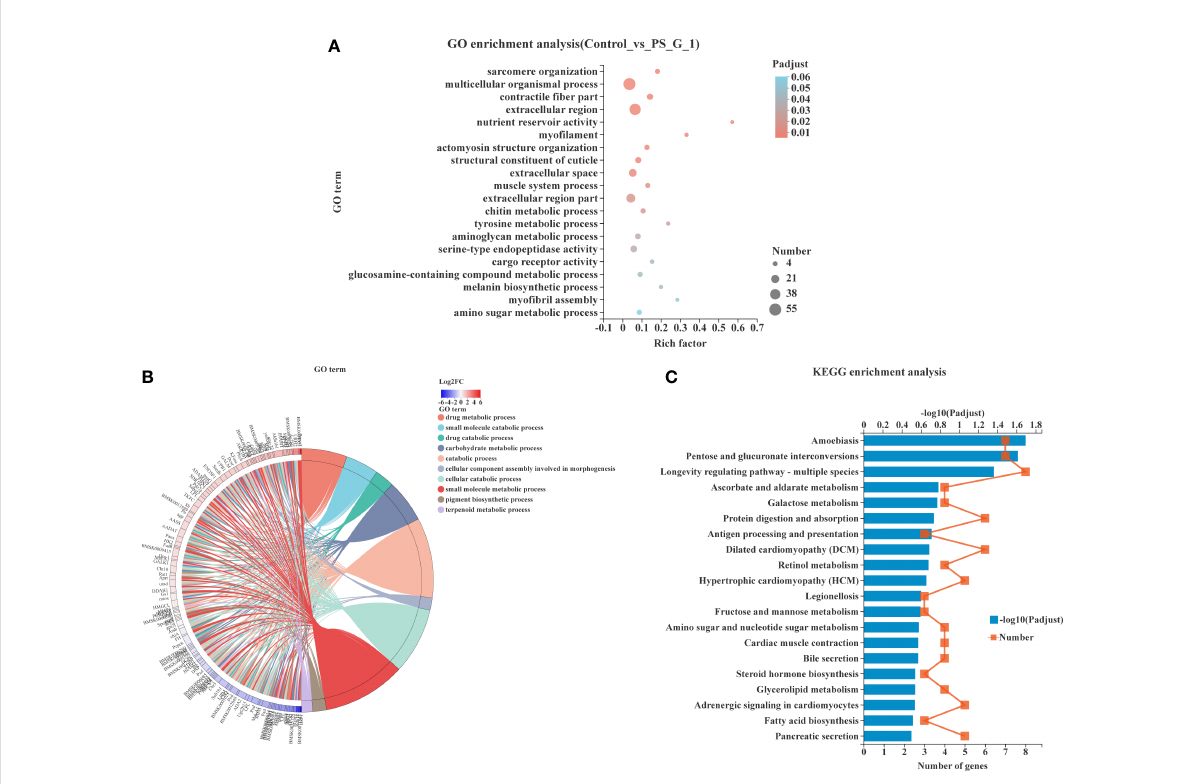
FIGURE 5 Functional enrichment analysis of differentially expressed genes (DEGs). (A) Gene Ontology (GO) enrichment of DEGs in silkworm exposed to Poria cocos polysaccharides (PS). (B) Chord plot indicating the relationship of the most involved genes and the top 10 terms of GO. (C) Kyoto Encyclopedia of Genes and Genomes pathway enrichment analysis of DEGs in silkworm exposed to